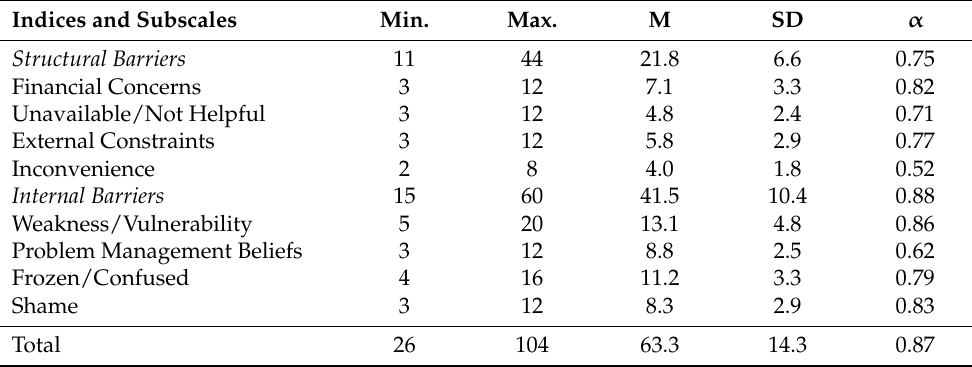
Table 8. Descriptive results and alpha values for the BHS-TR scale ( n =